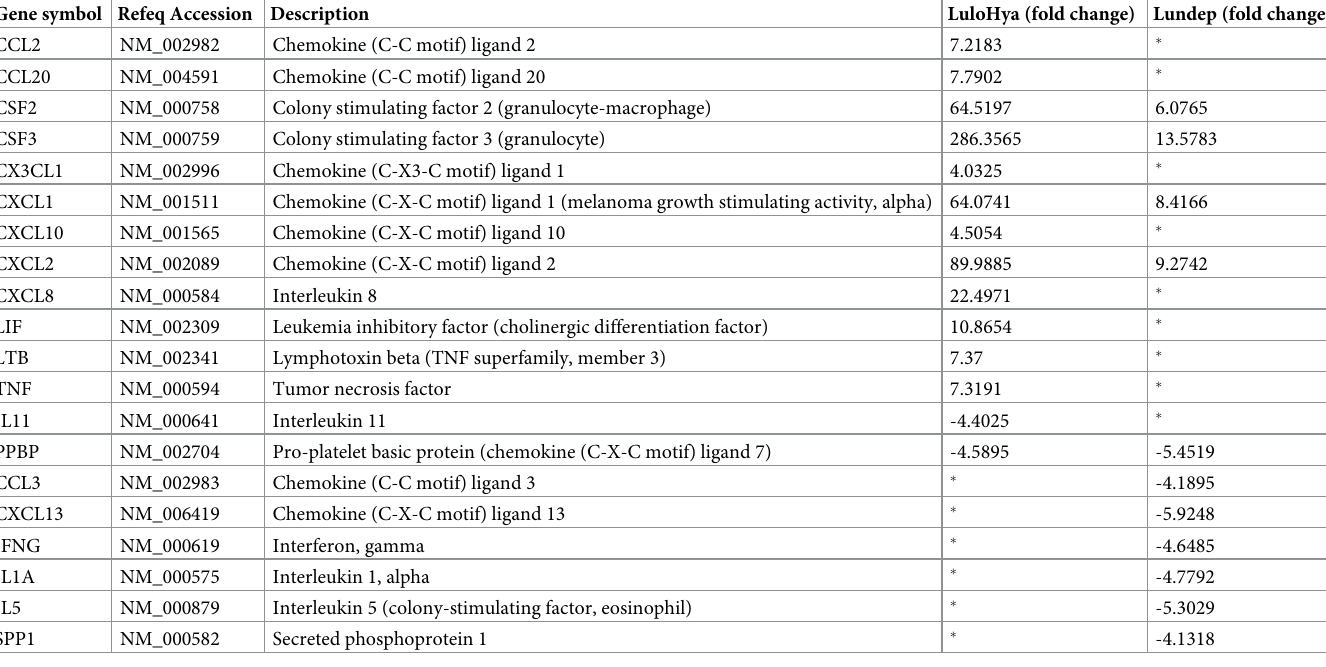
Table 1. Cytokine and chemokine gene expression in the presence of salivary proteins LuloHya and Lundep. Gene symbol Refeq Accession Description LuloHya (fold change) Lundep (fold change)